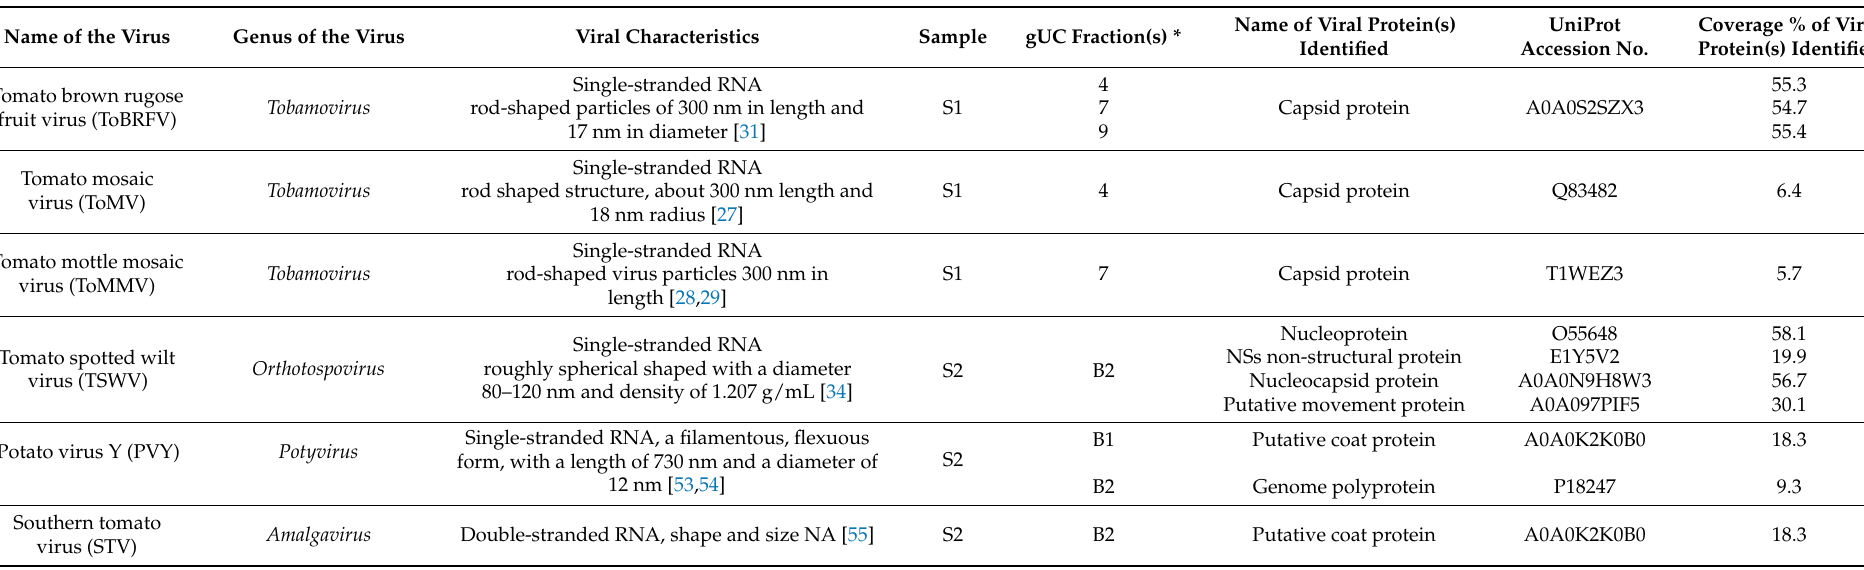
Table 2. Viral proteins identified by proteomics in two tomato-derived nanovesicles samples (S1 and S2) and separated by gradient ultracentrifugation into fractions. * gUC fraction(s) where the viral protein(s) was (were) highly expressed based on protein ranking reported in Supplementary Materials Table